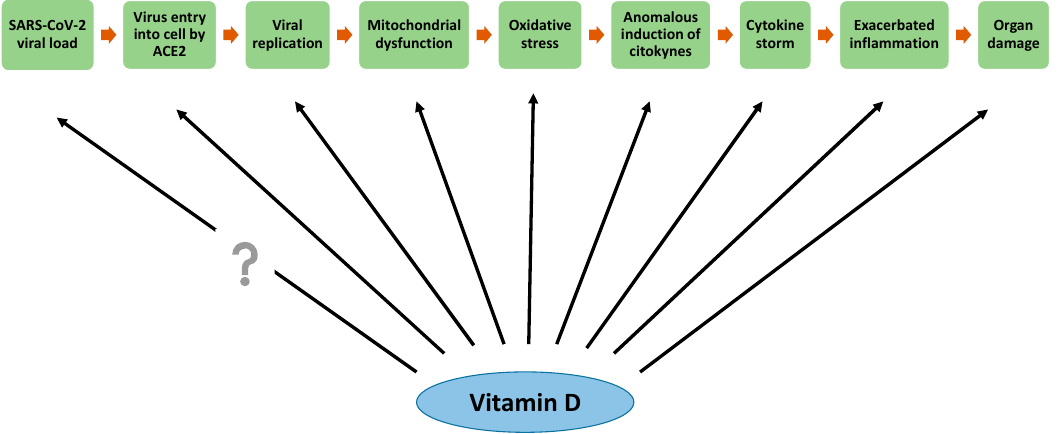
Figure 2. Possible participation of vitamin D on stages of SARS-CoV-2 infection.